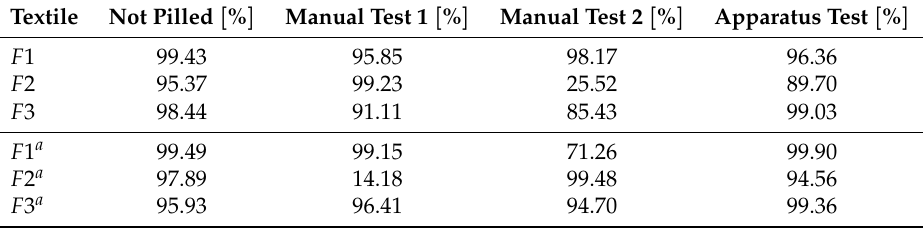
Table 4. Contributions of the PC 1 principal component in the representation of observations in